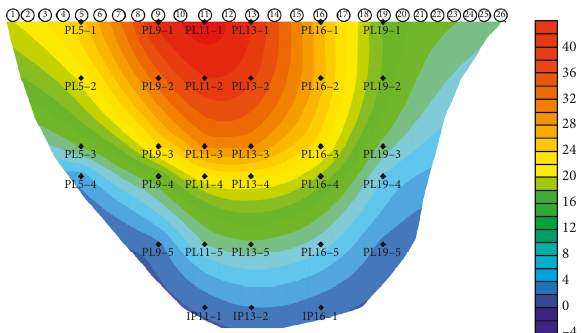
Figure 6: Radial displacement increment nephogram (to the downstream is positive).